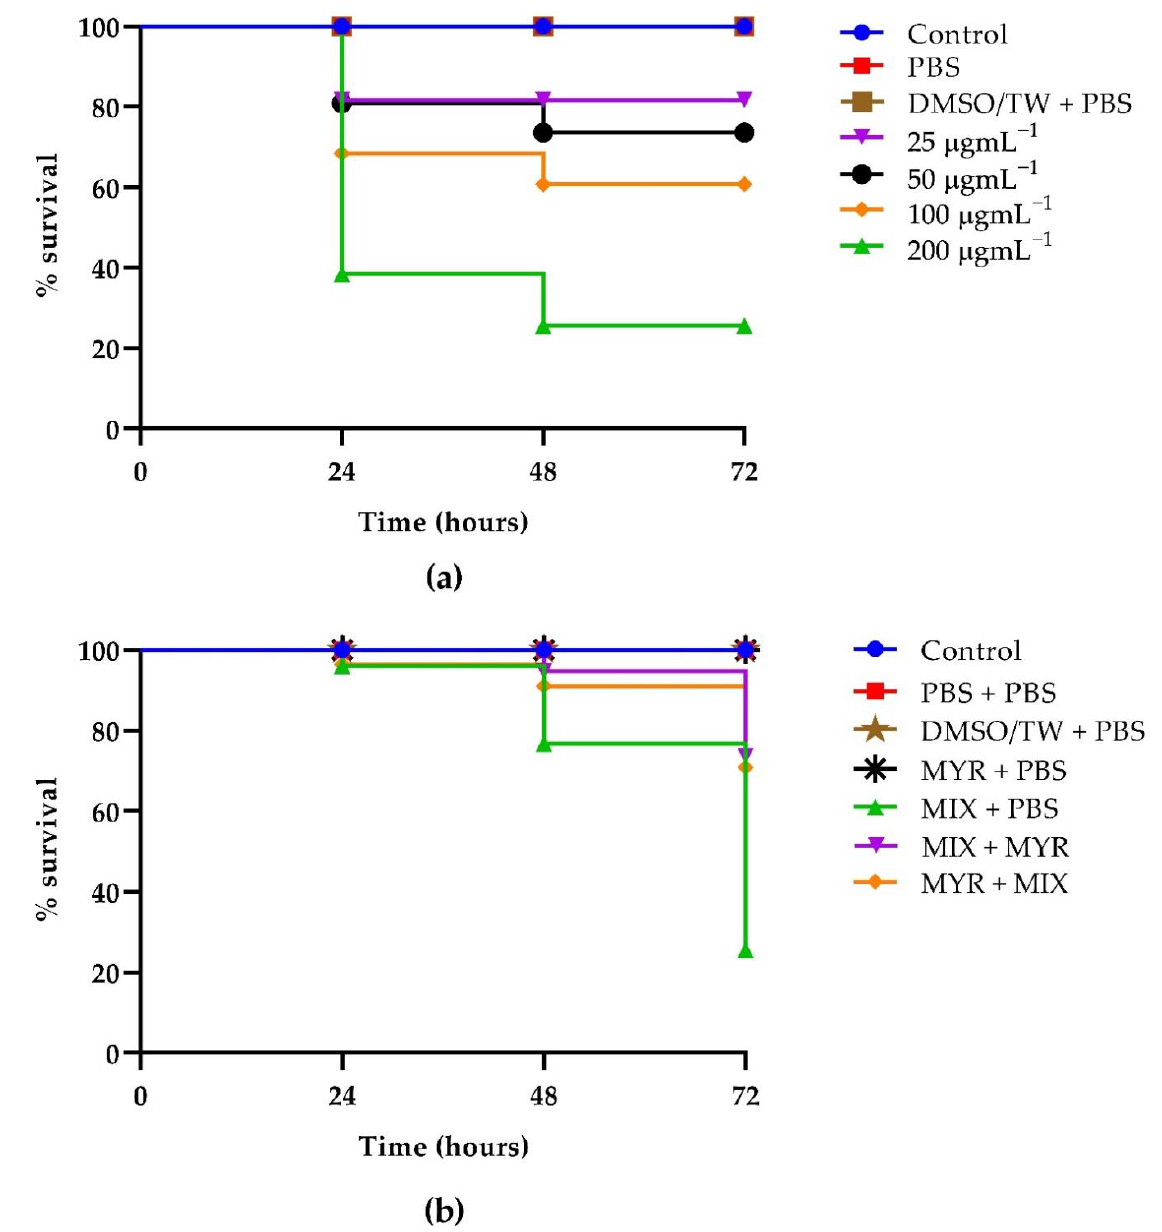
Figure 6. Combined activity of MYR with CAS ( a , b ) and MEM ( c , d ) against dual-species biofilm of C. auris and K. pneumoniae ; panels a and c show checkerboard assay, and panels b and d show per- centage of inhibition of biofilm formation. Stars indicated indicate synergy (FICI ≤ 0.5); **** = p < 0.0001 (Dunnett’s test).